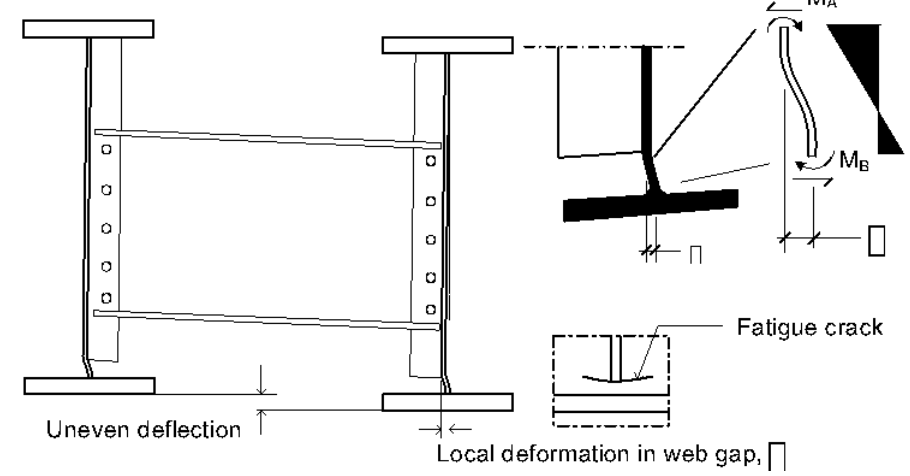
Figure 12. The differential deflection of bridge girders results in high local bending stresses in unstiffened web gaps between the girder flange and the termination of cut-short connection plates.